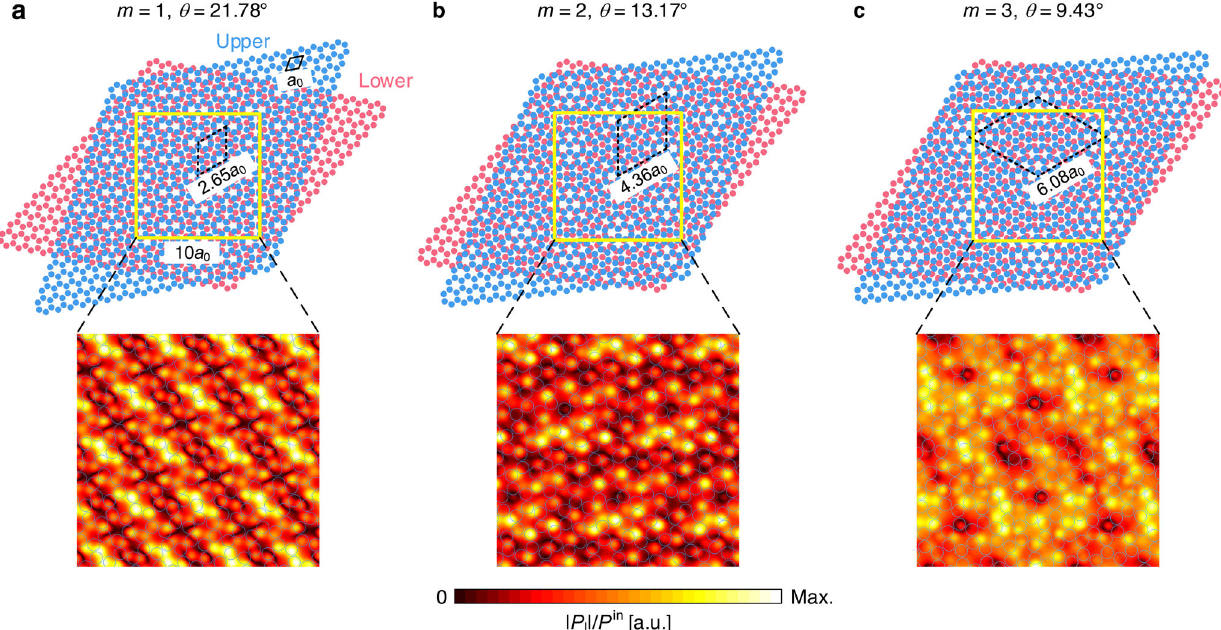
Fig. 4 Schematic and Moiré pressure fi elds at the Dirac cones for three different superlattices. The fi eld plot regions correspond to the red circles in the band diagram of Fig. 2, with a m = 1, b m = 2, and c m = 3, respectively, and the geometrical parameters h g = 0.8 a 0 and h 1,2 = 2 a 0 . At the plane z = − 0.001 a 0 we map the normalized pressured fi elds | P I |/ P in . Here, the blue circles in the contour plots indicate the holes' positions on the upper plate.